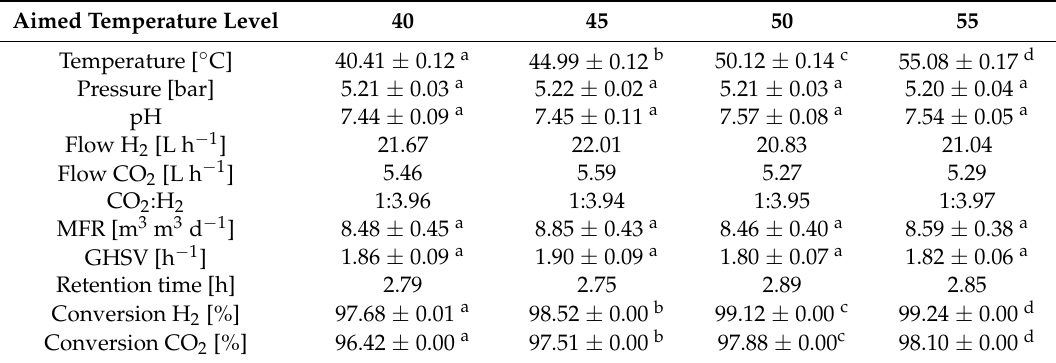
Table 1. Overview of the operating parameters, flow rates and conversion. The results of the three reactors were calculated as an arithmetic average. The significant differences among the temperature levels are marked with different letters ( p < 0.05, Tukey’s